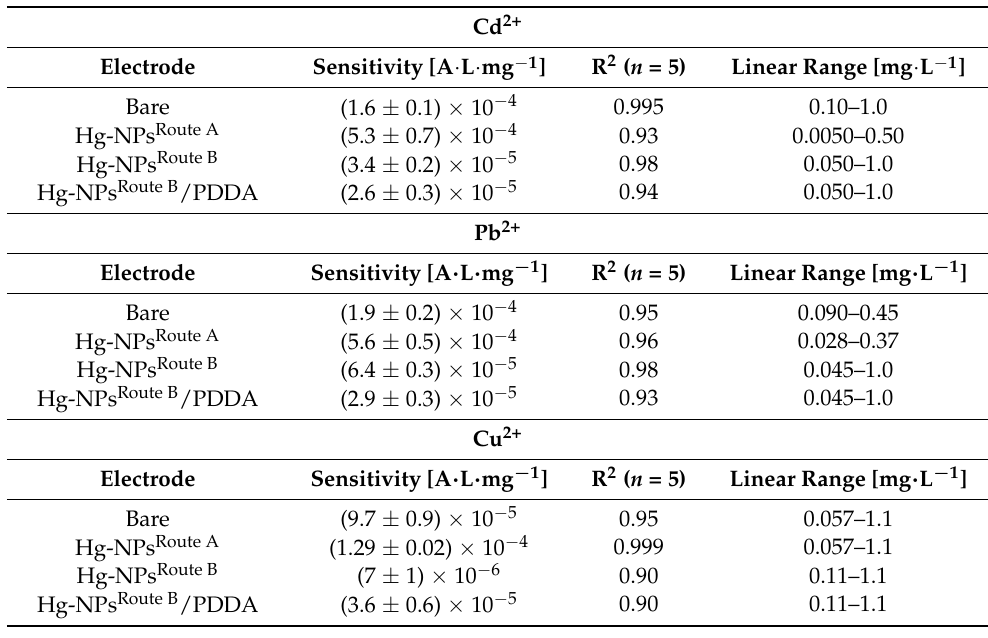
Table 1. Electroanalytical performance by SWASV of the electrodes for all metal cations analyzed